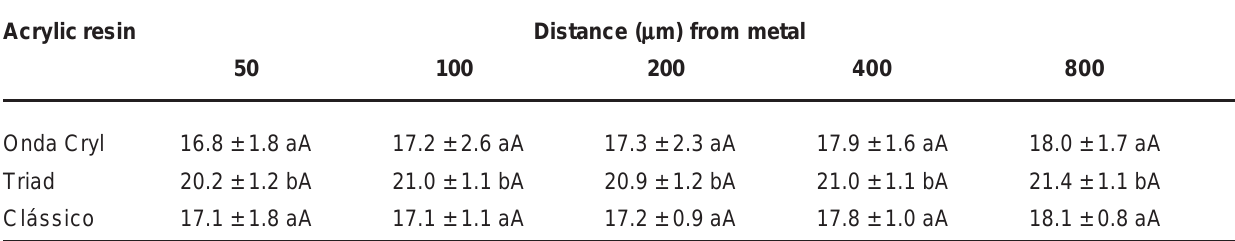
Mean followed by different letters are statistically different (p<0.05) Lowercase letters indicate differences between acrylic resins and uppercase letters indicate differences between distances from